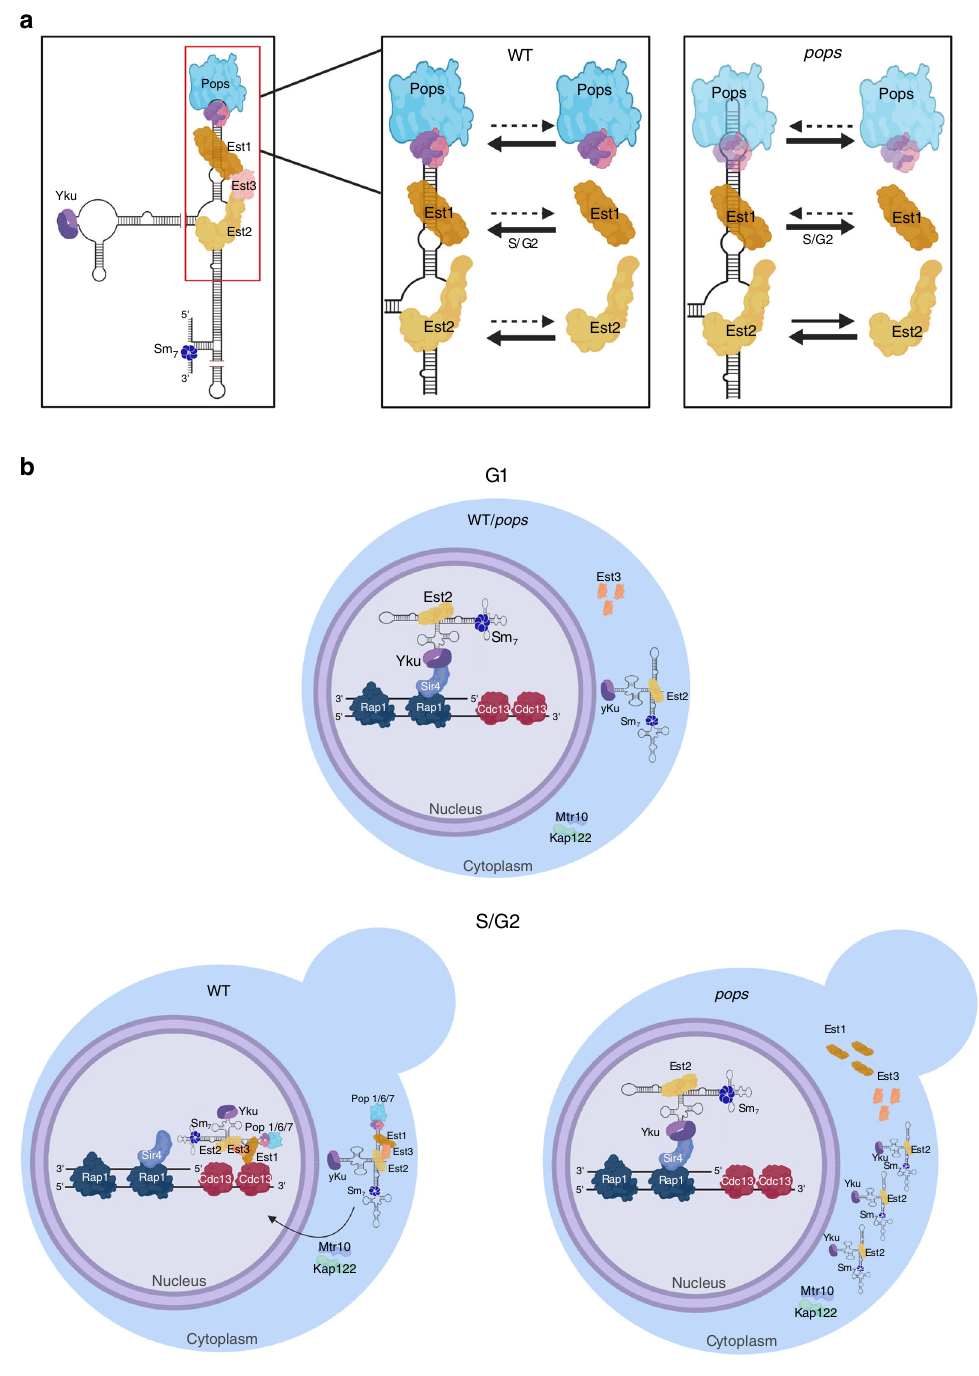
Fig. 10 Working model for how Pop proteins affect the maturation and localization of telomerase. a Our data indicate that the Pop proteins are important to stabilize the binding of Est1 (and hence Est3) (and to a lesser extent Est2) to TLC1 RNA. As the cell progresses into late S phase, reduced levels of Pop1 or Pop6 result in lower amounts of stable holoenzyme. We propose that the import factors that promote the re-entry of TLC1 and its associated proteins to the nucleus recognize only the holoenzyme. As a result, TLC1 accumulates in the cytoplasm in pop cells. b In WT cells, during G1 phase, TLC1 RNA binds to telomeric chromatin via a TLC1-Yku/Sir4/Rap1 interaction 3,18 . The G1 phase binding of telomerase to telomeres is less stable than its association in late S/G2 phase 20 . Chromatin bound G1 telomerase is unable to lengthen telomeres as it lacks two essential subunits, Est1 and Est3 2,4 , and is not engaged at the chromosome end 19 . The abundance of core telomerase subunits is fairly constant throughout the cell cycle except for Est1, whose abundance is low in G1 and peaks in late S/G2 phase 2,4,6 owing to ubiquitin mediated proteolysis 5,6 . Est1 is required to recruit Est3 and form the telomerase holoenzyme 4,6 . Therefore, the telomerase holoenzyme, which assembles in the cytoplasm, is present only in late S/G2 phase. The holoenzyme is transported to the nucleus with the help of import factors such as Mtr10 and Kap122 13,14 . In late S/G2 phase, telomerase engages the single- strand G-tails via a Cdc13-Est1 interaction. Either the G1 or the late S/G2 recruitment pathway is suf fi cient to maintain telomeric DNA, but the Cdc13/Est1 interaction is essential for telomerase activation 18 . In both WT and pop cells, the TLC1-Ku/Sir4/Rap1 interactions brings Est2 to telomeres during G1 phase. In late S/G2 phase, reduced levels and/or activity of Pop proteins, lead to instability of the telomerase holoenzyme. The unstable holoenzyme is less likely to be bound by import factors which results in its cytoplasmic accumulation. Images were made in ©BioRender